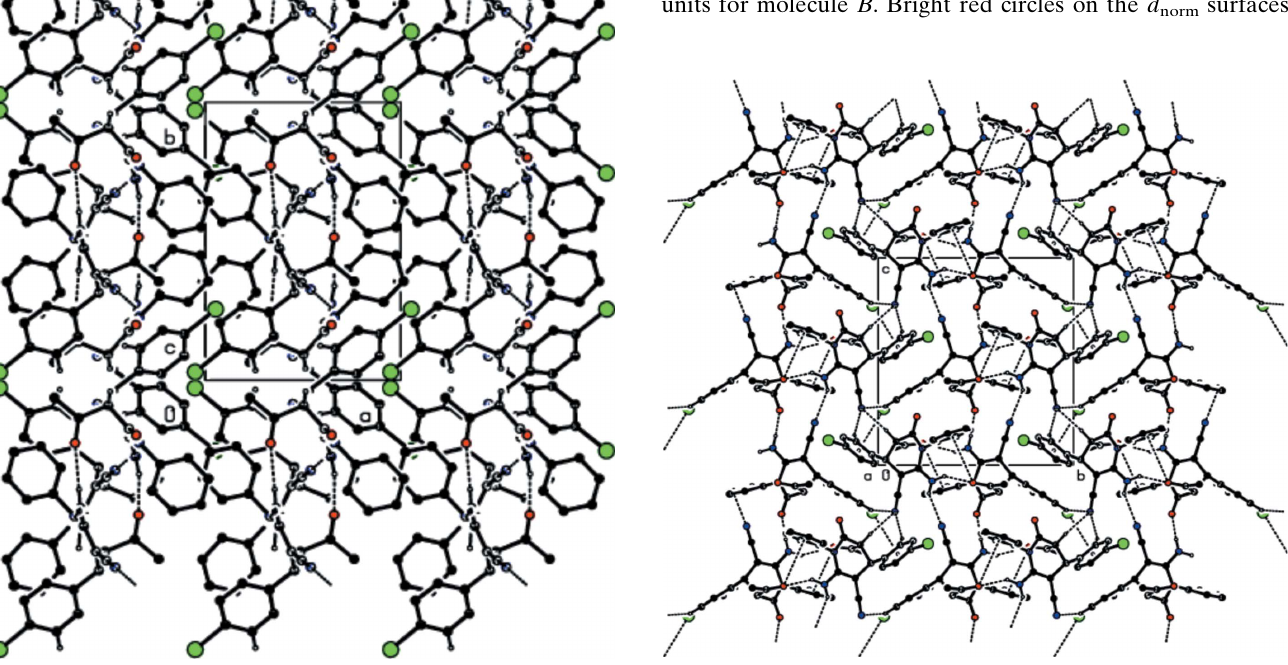
Figure 5 The crystal packing of the title compound viewed down the c axis, with intermolecular N—H (cid:2)(cid:2)(cid:2) O, C—H (cid:2)(cid:2)(cid:2) N and N—H (cid:2)(cid:2)(cid:2) N hydrogen bonds.